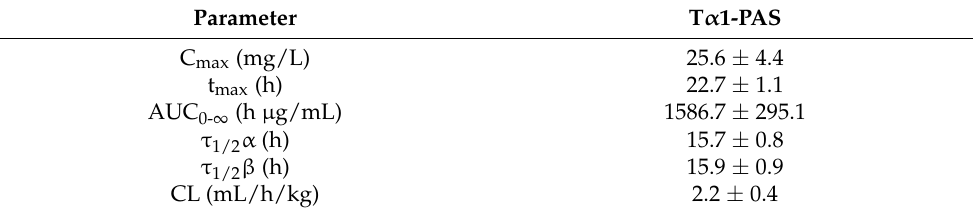
Figure 4. PK study of N-acetylated T α 1-PAS in rats. T α 1-PAS was subcutaneously injected at a dose of 3.4 mg/kg b.w. into female Wistar rats ( N = 5). The concentration of the fusion protein in plasma was quantified using sandwich ELISA. Data were plotted against the sampling time post injection (p.i.) and fitted using a one-compartment model. The PK profile shows distinct absorption and elimination phases (for PK parameters, see Table 1). Table 1. Pharmacokinetic properties of T α 1-PAS in